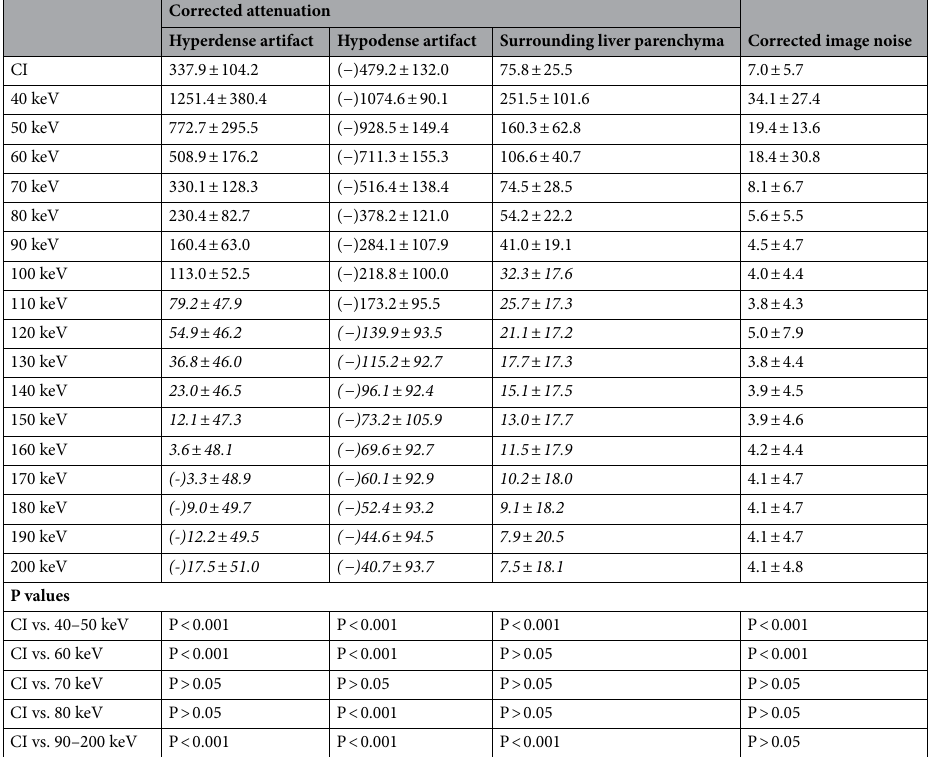
Table 2. Quantitative assessment of artifact reduction and surrounding liver parenchyma. CI conventional images. Data in italics indicate no statistical significance between any two energy